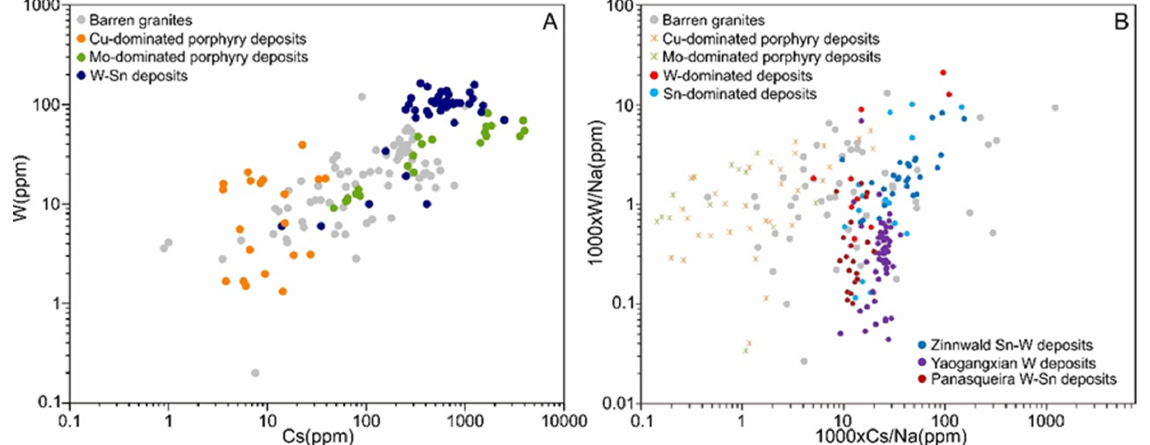
Figure 14. Diagrams of W vs. Cs concentration or concentration ratios of melt inclusions and fluid inclusions from mineralized, barren and porphyry systems. ( A ) W vs. Cs concentration diagram for melt inclusions of W-associated and barren granite, also shown are porphyry Cu and porphyry Mo systems. Barren granites include: Rito del Medio, Huangshan and Mt. Malosa [182,195,196]; Cu-dominated porphyry deposits include: Elatsite [123]. Mo-dominated porphyry deposits include: Climax [193]. W-Sn deposits include: Mole Granite and Ehrenfriedersdorf [85,182]. ( B ) W/Na vs. Cs/Na ratios for initial fluids of mineralized and barren fluids, adopted from the database of [180]. Fluid compositions from three wolframite-bearing quartz vein-type deposits, i.e., Zinnwald, Yaogangxian and Panasqueira, are also plotted for comparison. Values are from [13], [15] and [17],